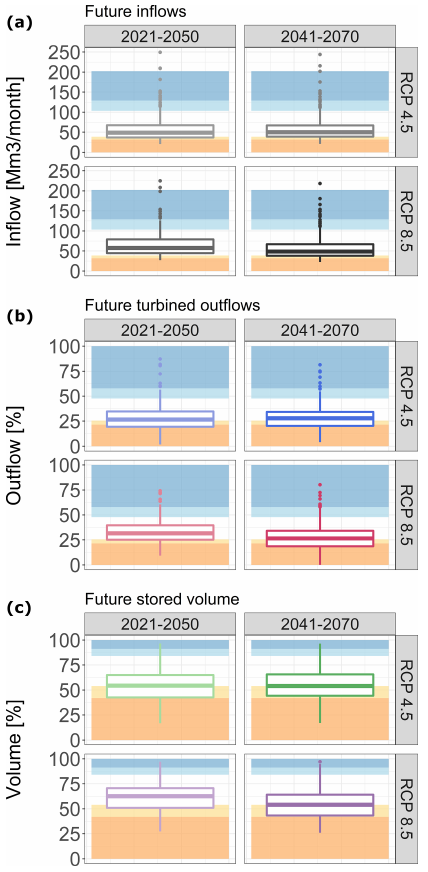
Figure 5. Thirty-year slice boxplots for future projections of (a) simulated water inflow to the S. Giustina reservoir, (b) simu- lated turbined water and (c) simulated future water volume stored in the S. Giustina reservoir. Coloured bands outline areas of baseline values lower than the 10th and 20th and greater than the 80th and 90th percentiles using the same colours as in Fig. 4. For an interpre- tation of the references to colour in this figure legend, the reader is referred to the web version of this